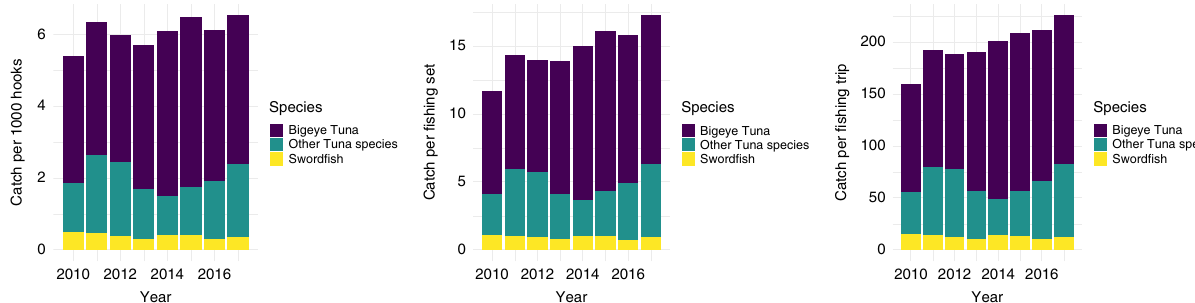
Fig. 3 Total catch-per-unit-effort by year for commercial pelagic fi sheries. Source: Annual hawaii limited access longline logbook summary reports from 2010 to 2017. Data are from All Sets (Tuna and Sword fi sh) and All Areas (inside monuments, inside and outside U.S. EEZ, etc.). The total catch is color- coded by species: Bigeye Tuna in dark purple, Other Tuna Species in dark teal, and Sword fi sh in yellow. Source data are provided as a Source Data fi